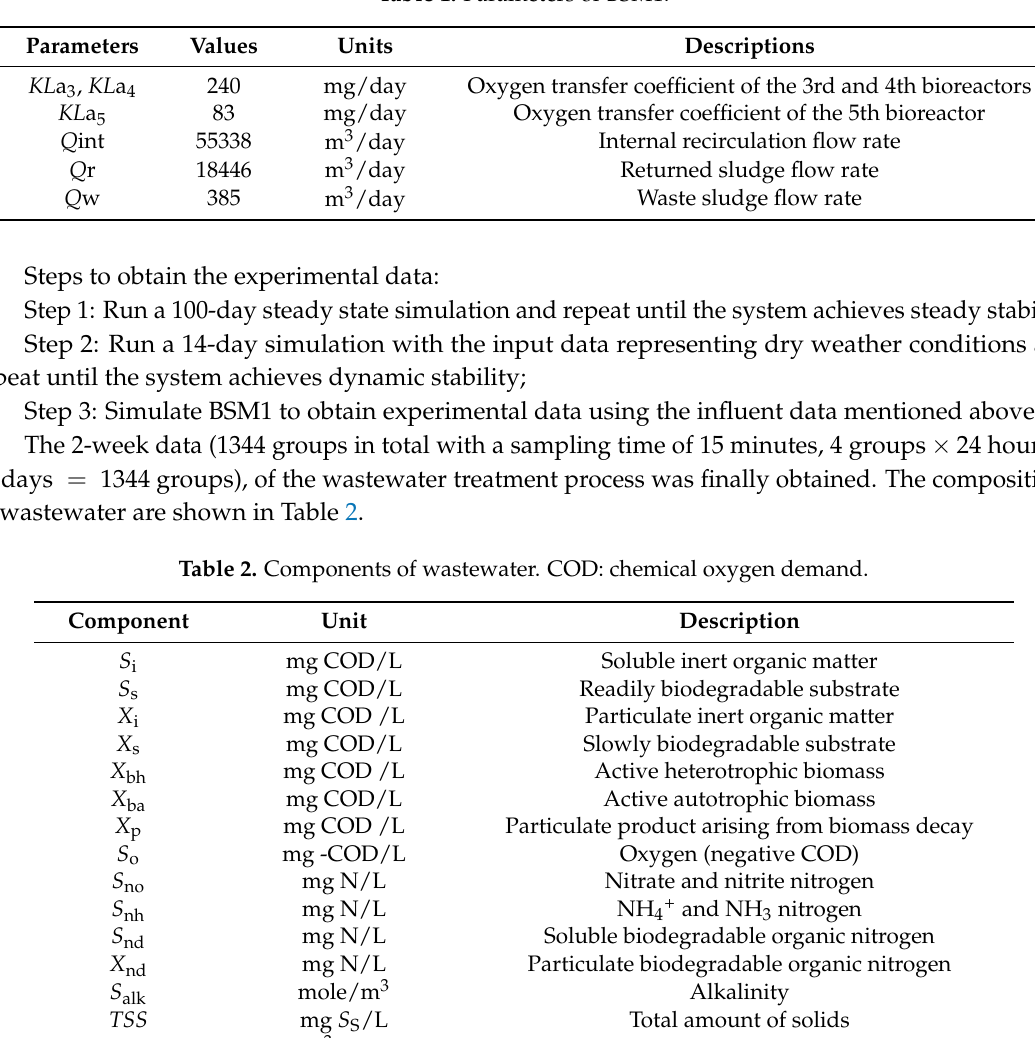
Table 1. Parameters of BSM1.